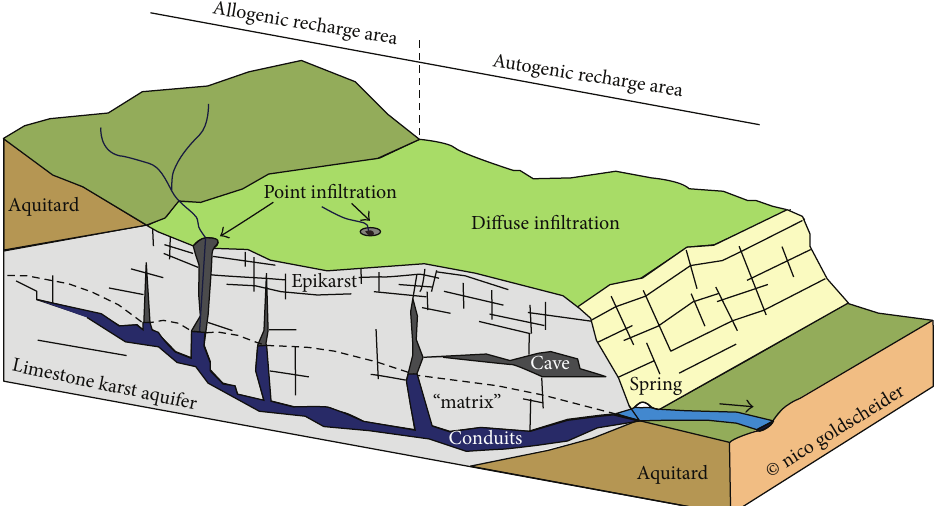
Figure 1: Example of heterogeneous karst aquifer illustrating the duality of recharge (allogenic versus autogenic), infiltration (point versus diffuse), and porosity/flow (conduits versus matrix)